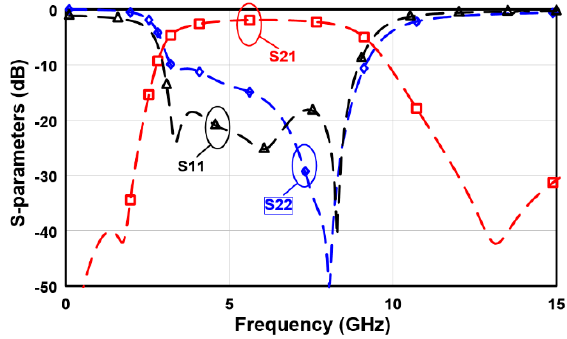
Figure 8. EM-simulated S parameters of the proposed filter on GaAs substrate.